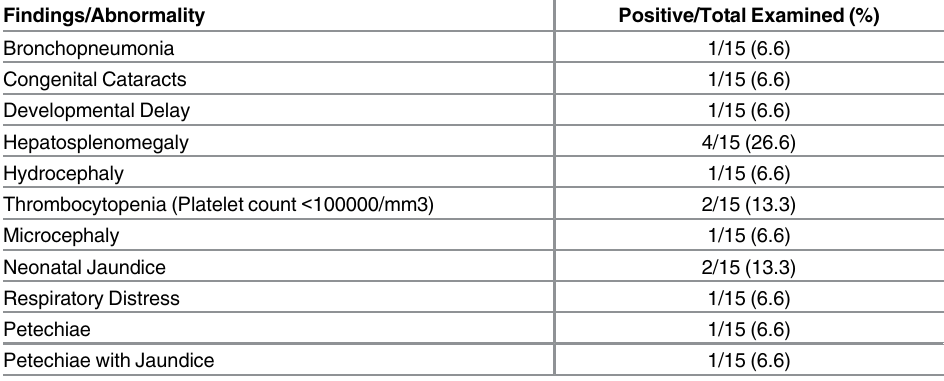
Table 5. Clinical Abnormalities found in Newborns with Symptomatic Congenital CMV